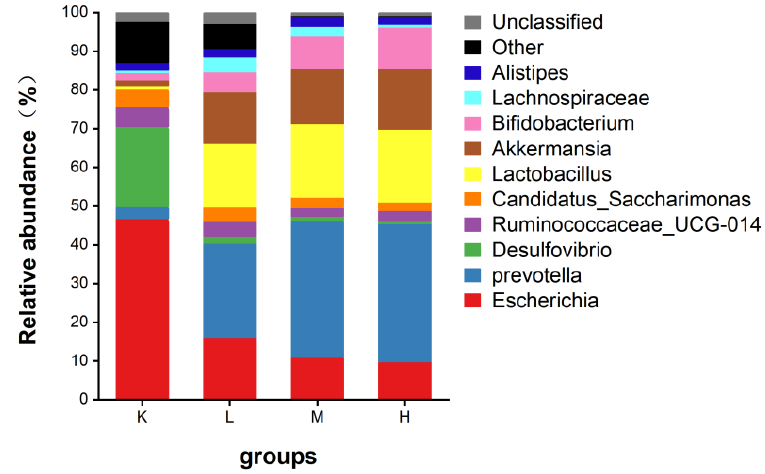
Figure 9. Heat map of species enrichment of gut microbiota in mice.